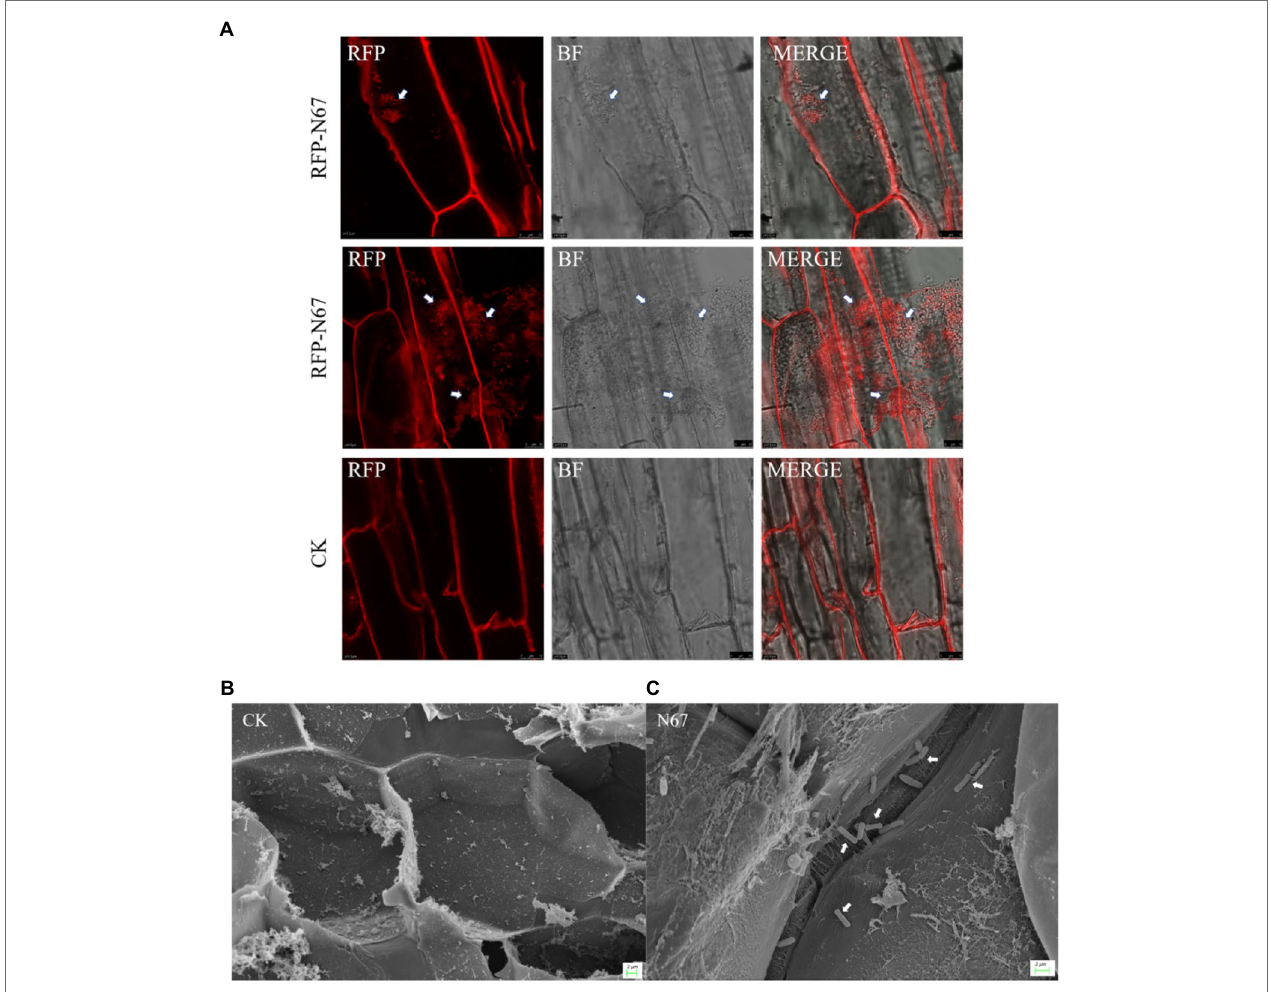
FIGURE 6 | Bacillus velezensis N67 colonies in banana roots. Banana roots were randomly selected 7 days after inoculant, and the roots were washed with sterile water to remove the medium and bacteria adhering to the surface. Tissue slices were cut out to Laser Confocal Microscopy (LCM) observation and subjected to critical point drying before Scanning Electron Microscopy (SEM) observation. (A) Representative fluorescent micrograph of RFP-N67 distributed in banana root cells. Scale bar: 10 μ m. (B) Scanning electron micrograph of control treatment that there were no any bacteria in the banana root cell. (C) Representative micrograph of RFP-N67 distributed in banana root xylem cells. The white arrows indicate the bacteria RFP-N67. Three replicates were used. Scale bar: 2 μ